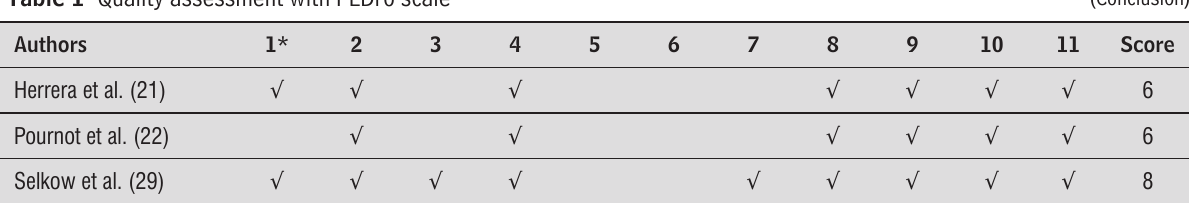
Table 1 - Quality assessment with PEDro scale Authors